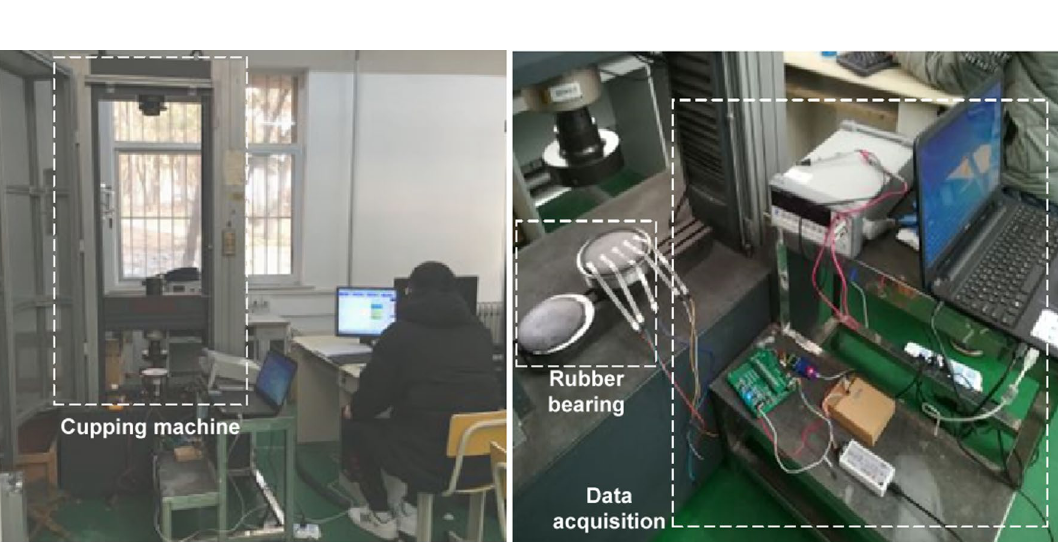
Figure 10. Loading and unloading experimental environment of bridge bearing monitoring